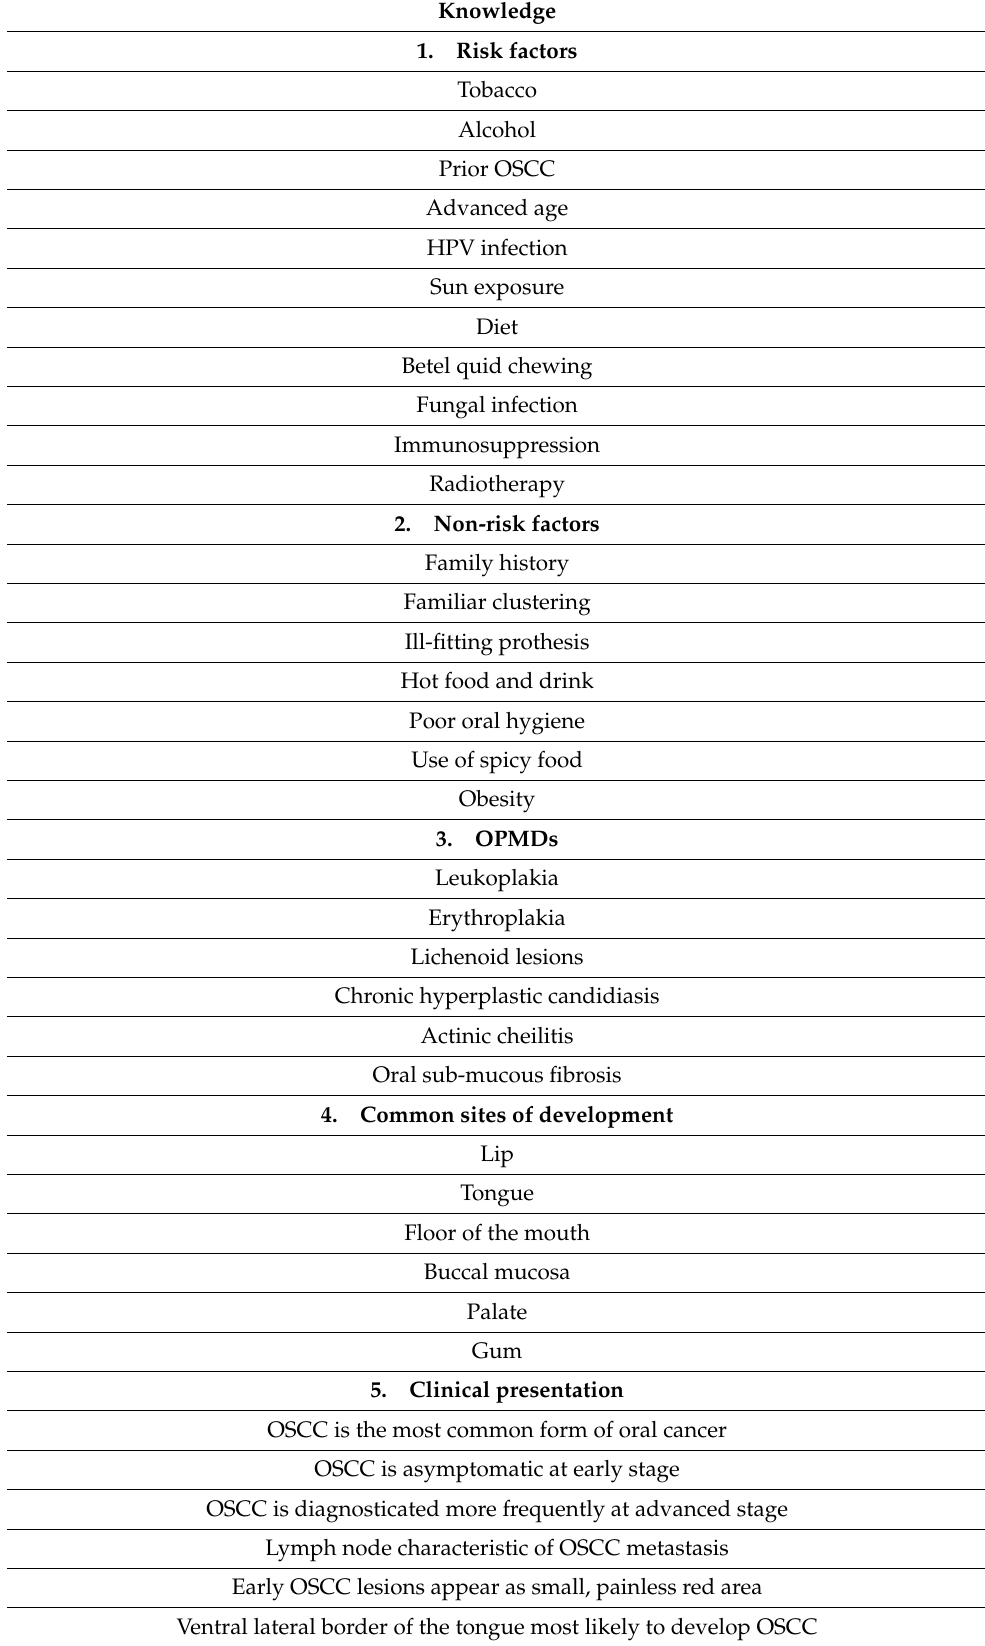
Table 2. OSCC-related items explored in the questionnaire-based